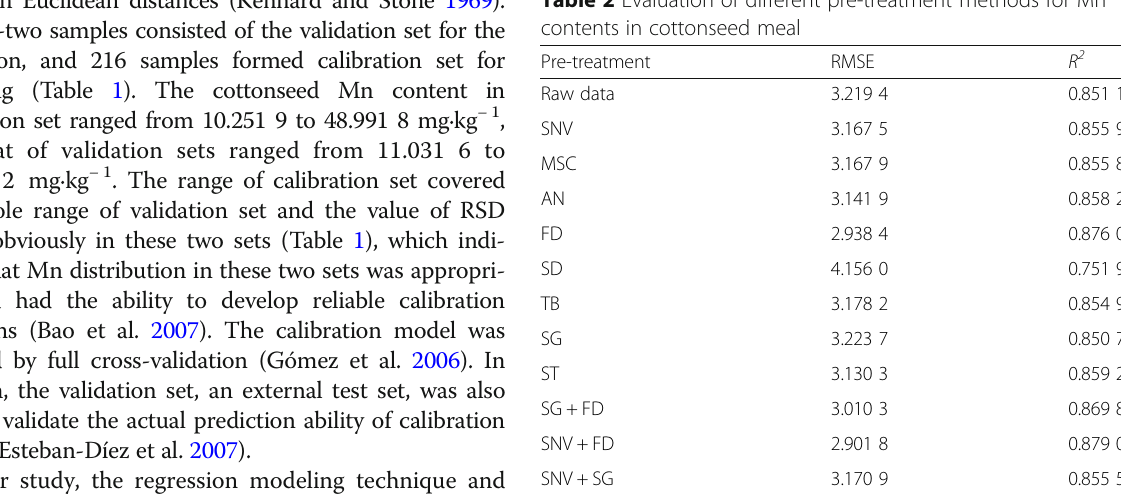
Table 2 Evaluation of different pre-treatment methods for